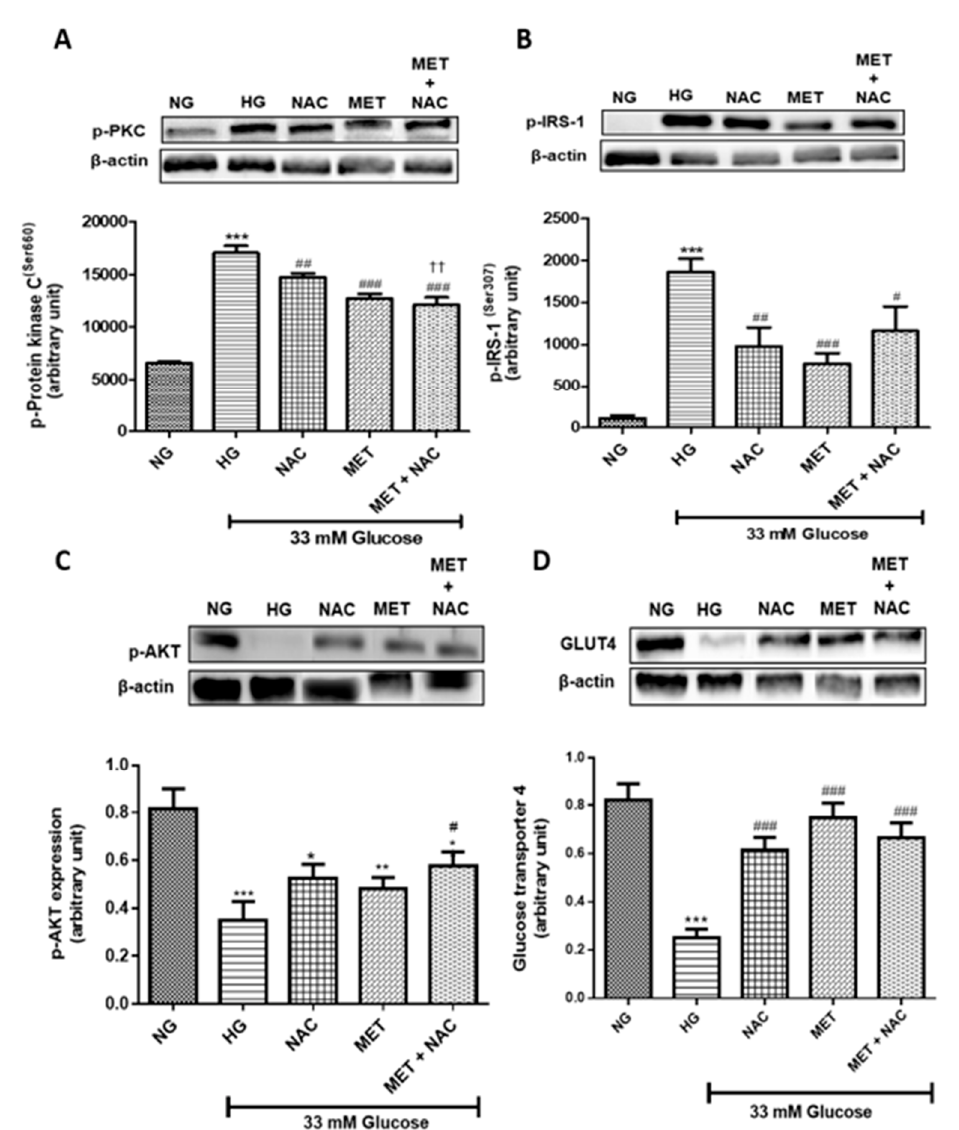
Figure 11. The combination effect of Metformin (MET) and N-acetylcysteine (NAC) on selected targets in the insulin signalling pathway. Protein expression of ( A ) protein kinase C phosphorylation at Serine 660 (p-PKC(Ser660)), ( B ) insulin receptor substrate-1 at Serine 307 (p-IRS-1(Ser307)), ( C ) protein kinase B phosphorylation at Serine 473 (p-AKT(Ser473)) and ( D ) glucose transporter 4 (GLUT4) protein expression of H9c2 cardiomyoblasts cultured in high glucose (HG; 33 mM) for 24 h. Thereafter, cells were treated with NAC (1 mM), metformin (MET) (1 µM) and a combination of MET+NAC. Cells treated with normal glucose (NG) served as the vehicle control. Results are expressed as the mean ± SEM of 3 Independent biological experiments with each experiment having 3 technical replicates ( n = 9). Significance is depicted as *** p ≤ 0.001 versus NG control, # p ≤ 0.05, ## p ≤ 0.01 and ### p ≤ 0.01 versus HG control, ‡ p ≤ 0.05 versus NAC.